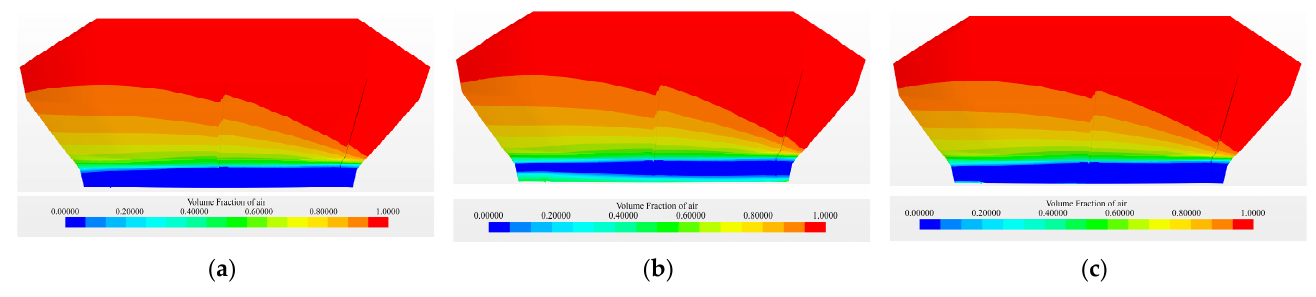
Figure 17. Volume fraction of air of the strut: ( a ) Without air injection; ( b ) Injected from L1, Air fl ow rate = 24 L/s; ( c ) Injected from L3, Air fl ow rate = 24 L/s. The volume fractions of air of the strut are shown in Figure 17, in which the di ff erent colors represent di ff erent volume fractions of air. In the dark red area, the volume frac- tion of air = 1, while the volume fraction of air = 0 in the dark blue area. The yellow area is the water splash range. By Figure 17, it can be seen that the air injected from loca- tion L1 could increase the air volume fraction of the bo tt om of the strut, which is the reason for the negative ∆𝑅 (cid:3020),(cid:3020) , as shown in Figure 16b. By Figure 17, it can be seen that the air injected from location L3 could increase the height of the water splash e ff ect, which is the reason for the positive ∆𝑅 (cid:3020),(cid:3020) , as shown in Figure 16b. 4.3. E ff ect on the Di ff erent Areas of the Underwater Body The computed result of resistance and drag reduction in di ff erent areas of the un- derwater body is shown in Figure 18. ( d ) Figure 18. Resistance of di ff erent areas of the underwater body: ( a ) Total resistance of A1; ( b ) Total resistance of A2; ( c ) Total resistance of A3; ( d ) Total resistance of A4. 0